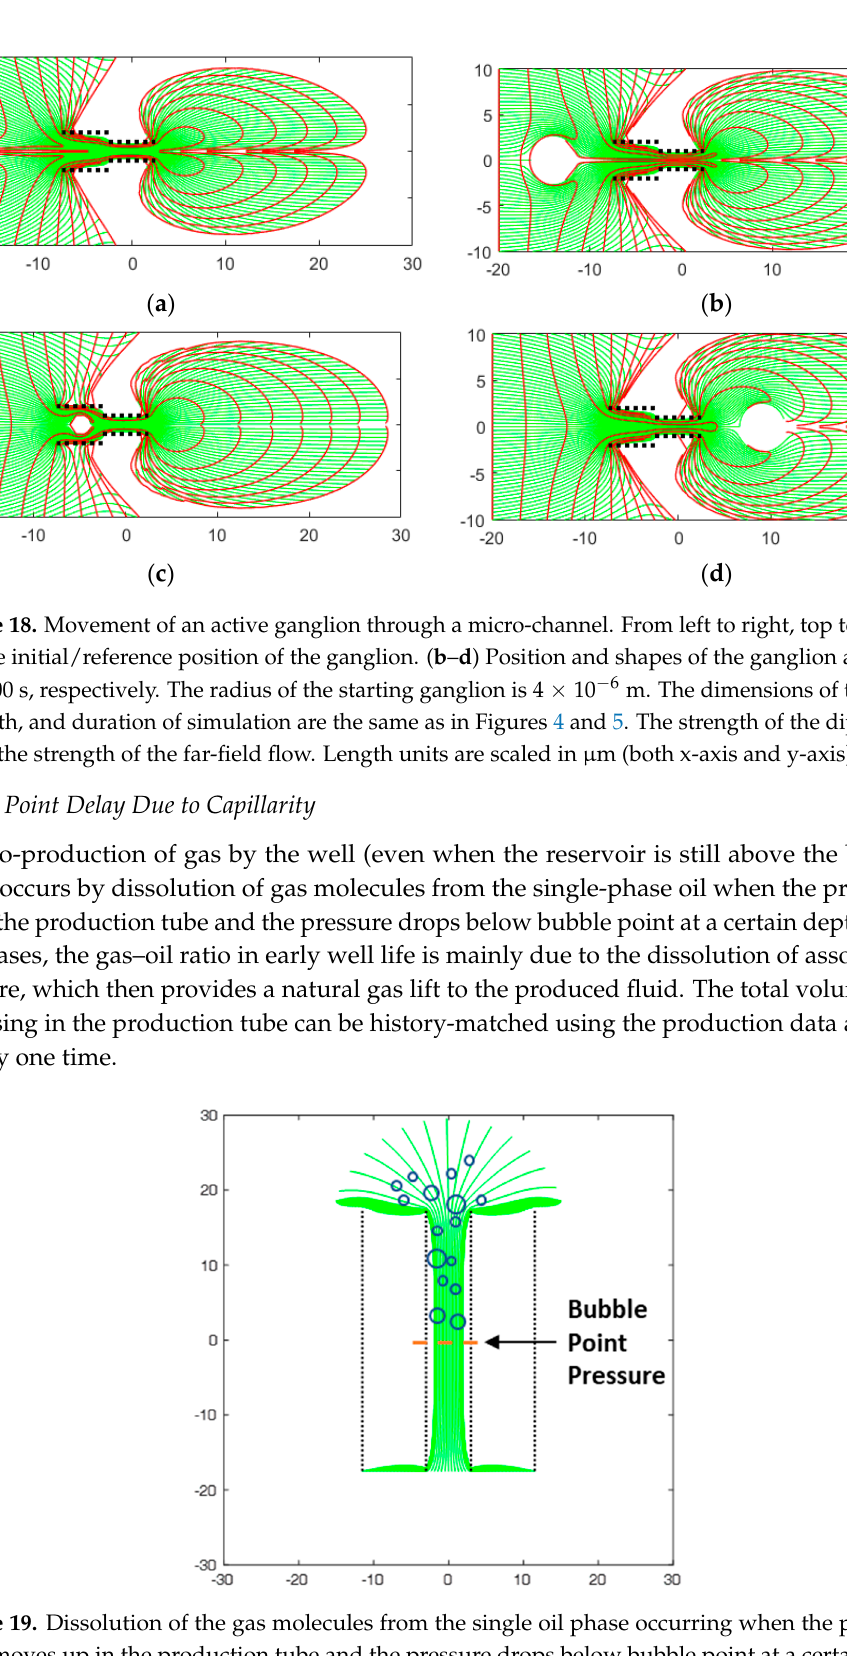
17 of 39 Figure 17. Principal sketches of non-wetting phase (e.g., oil, red) in interfacial contact with wetting phase (water or gas). ( a ) Fracture model shows a fracture space widening downstream (top) and narrowing (bottom). ( b ) Pore throat model showing stretching of oil ganglion during flow (top) and snapping into oil drops due to capillary forces when flow slows (bottom). Figure 18a–d shows the progressive movement of an active ganglion through an elementary pore model representing the reservoir space. Interfacial tension between two phases during a multi-phase flow, affecting the movement of the active ganglion with a surface tension, is represented by a dipole (which can be scaled as a surface tension effect) that resisted deformation during the movement through the pores (without the snapping effect, which requires implementation of Rankine flow elements). The radius of the point dipole is inversely proportional to the square root of the far-field flow velocity. The velocity of the far-field flow is accelerated in the